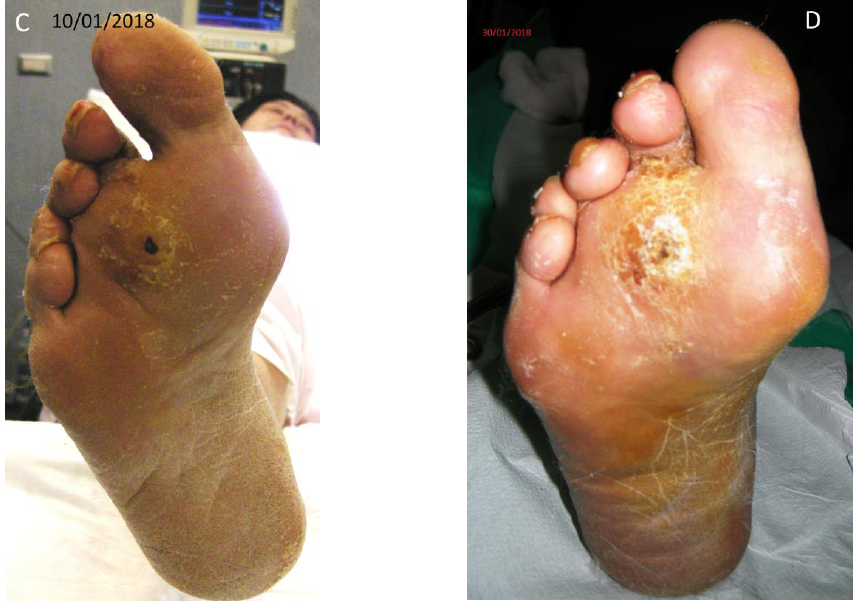
Figure 3. Case No. 3. ( A , C , D ) Different moments of the wound healing, stable after six months; ( B ) NMR with the bone lesion at the third metatarsal ray.